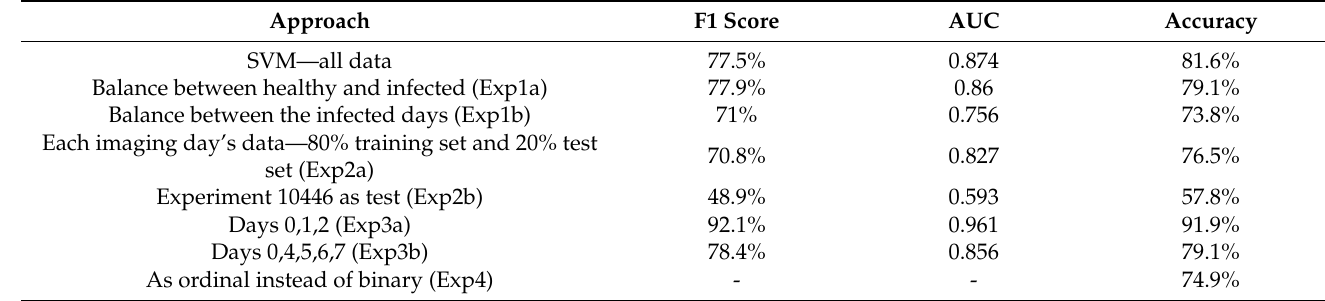
Table 11. A summary of all approaches and their results.